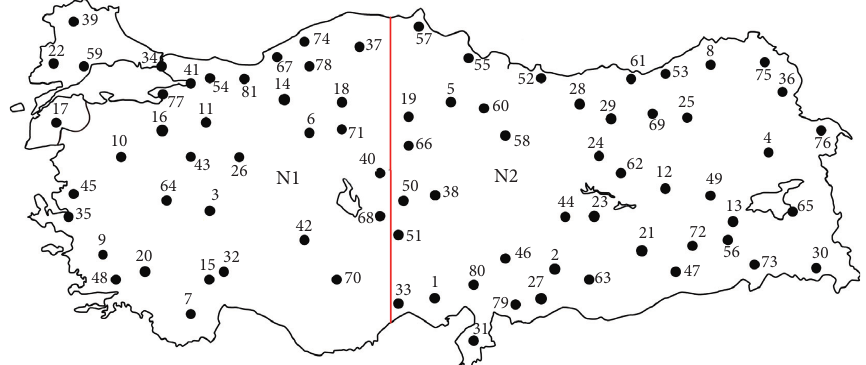
Figure 5: Turkish network.